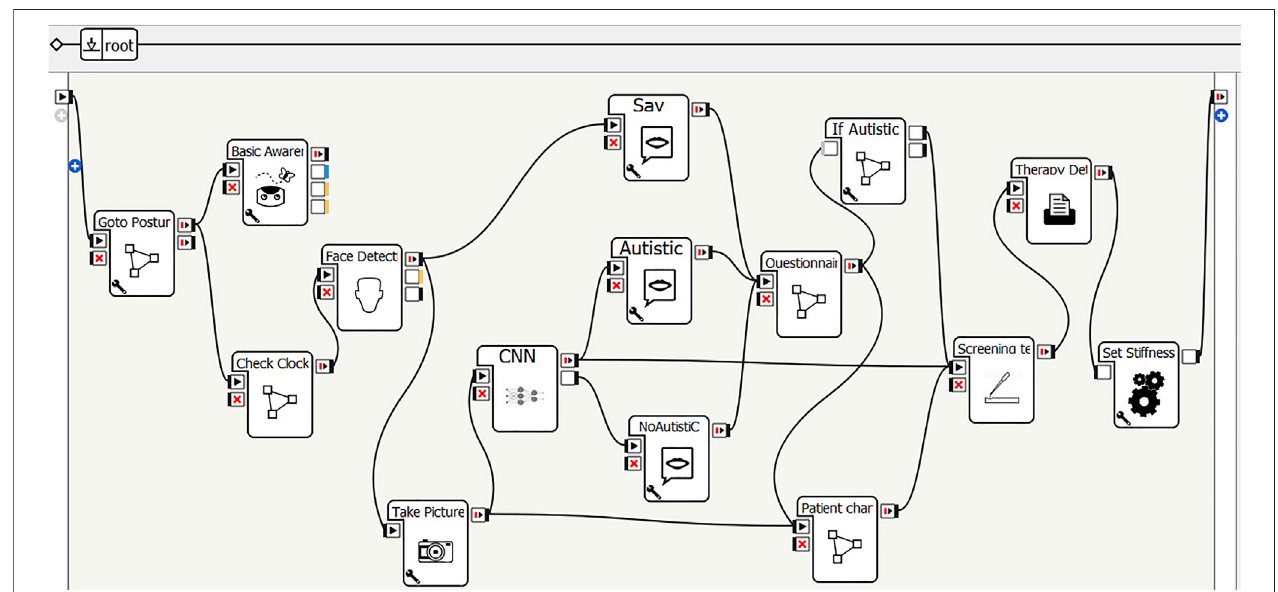
FIGURE 12 | Choregraphe program for the contextualization of the